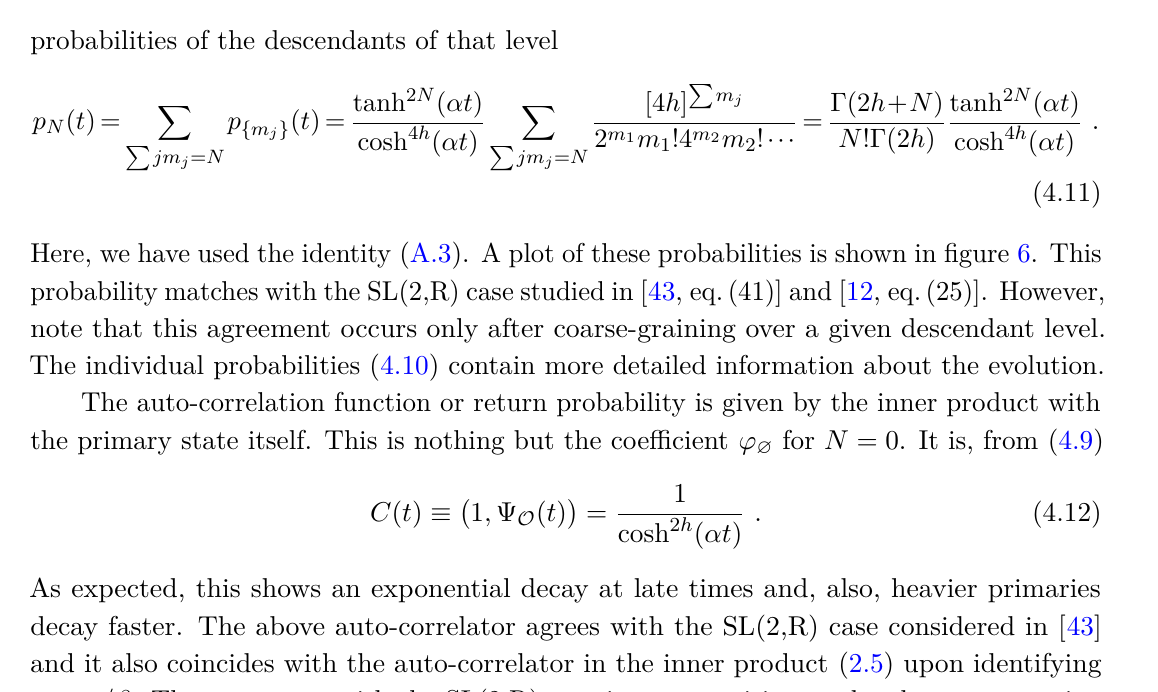
Figure 6 . Plot of the probabilities p N ( t ) , eq. (4.11), of being in descendant levels 0 to 20 with h = 15 . The probability of remaining in the primary state ( p ? ( t ) for N = 0 ) is shown by the red dashed